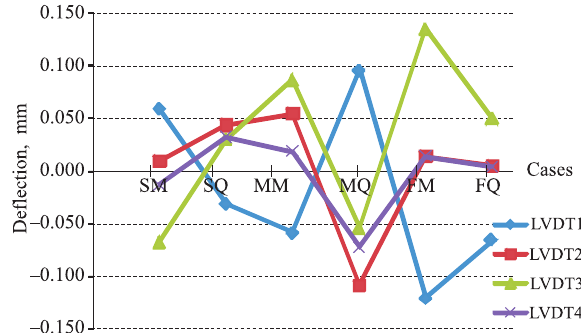
Fig. 22. Effect of vehicle location on slab deflection